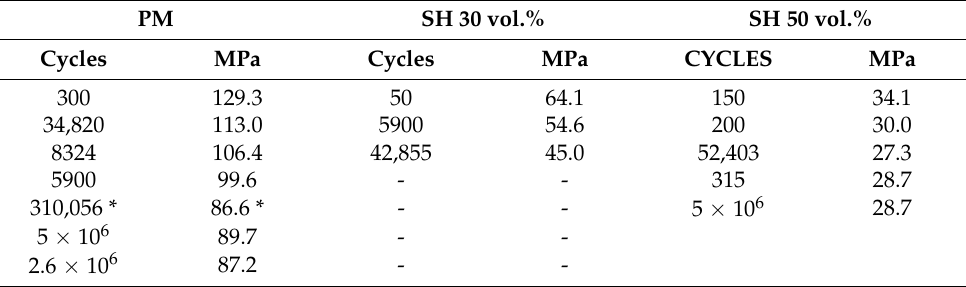
Table 2. Nominal stresses and the number of cycles in the fatigue tests.